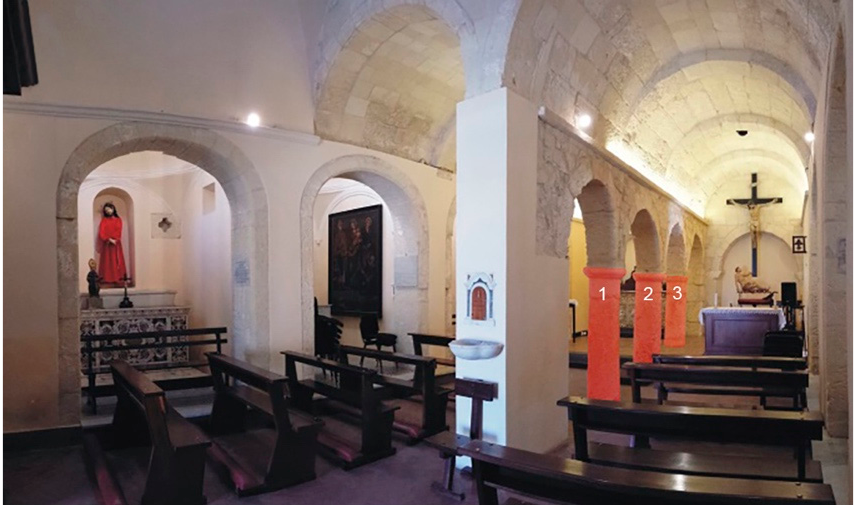
Figure 2. The three studied columns inside the church are highlighted in red and numbered as column 1, column 2, and column 3.